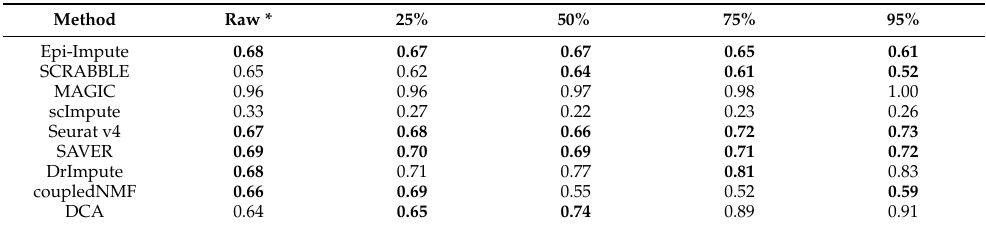
Table 1. Preservation of the “ground truth” gene-gene relationship (obtained by RNA FISH [14]) in the Drop-seq data [28] after imputation. Person correlation of expression levels between housekeeping genes BABAM1 and LMNA for the scRNA-seq data (n = 8498) with varying ratios of added dropouts (raw, 25%, 50%, 75% and 95%). The top 5 methods having the closest to the “ground truth” correlation, obtained using RNA FISH data ( r = 0.67) are marked in bold. * “Ground truth” correlation based on a RNA FISH data between BABAM1 / LMNA (n = 17,095) is r = 0.67 [14]. Method Raw * 25% 50%